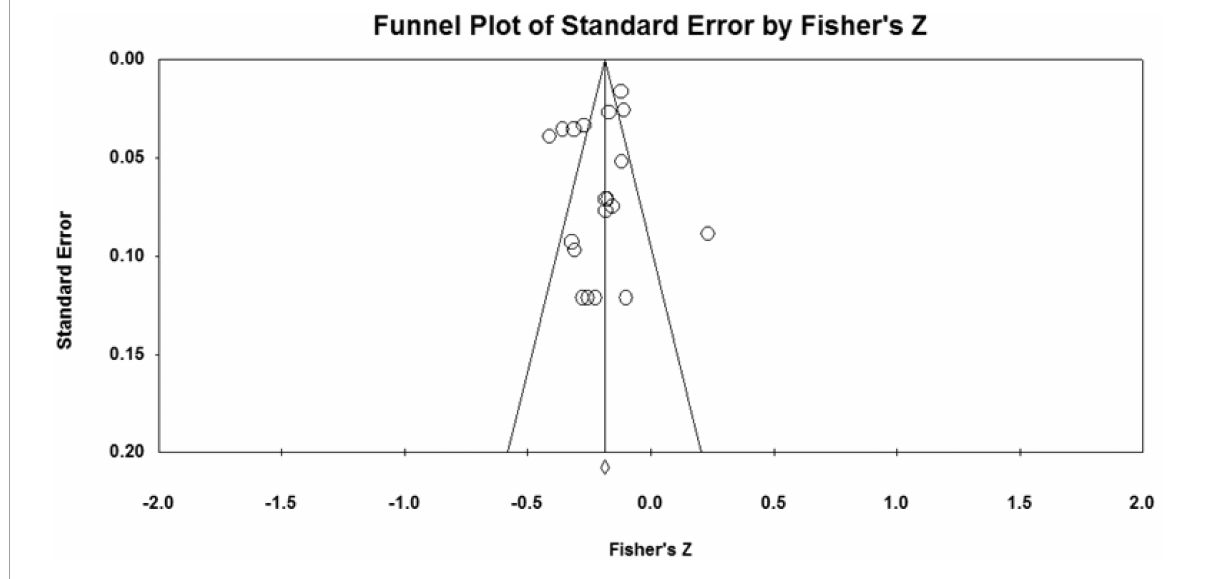
FIGURE2 Funnel plot of the relationship between authoritative parenting and sibling conflicts studies.